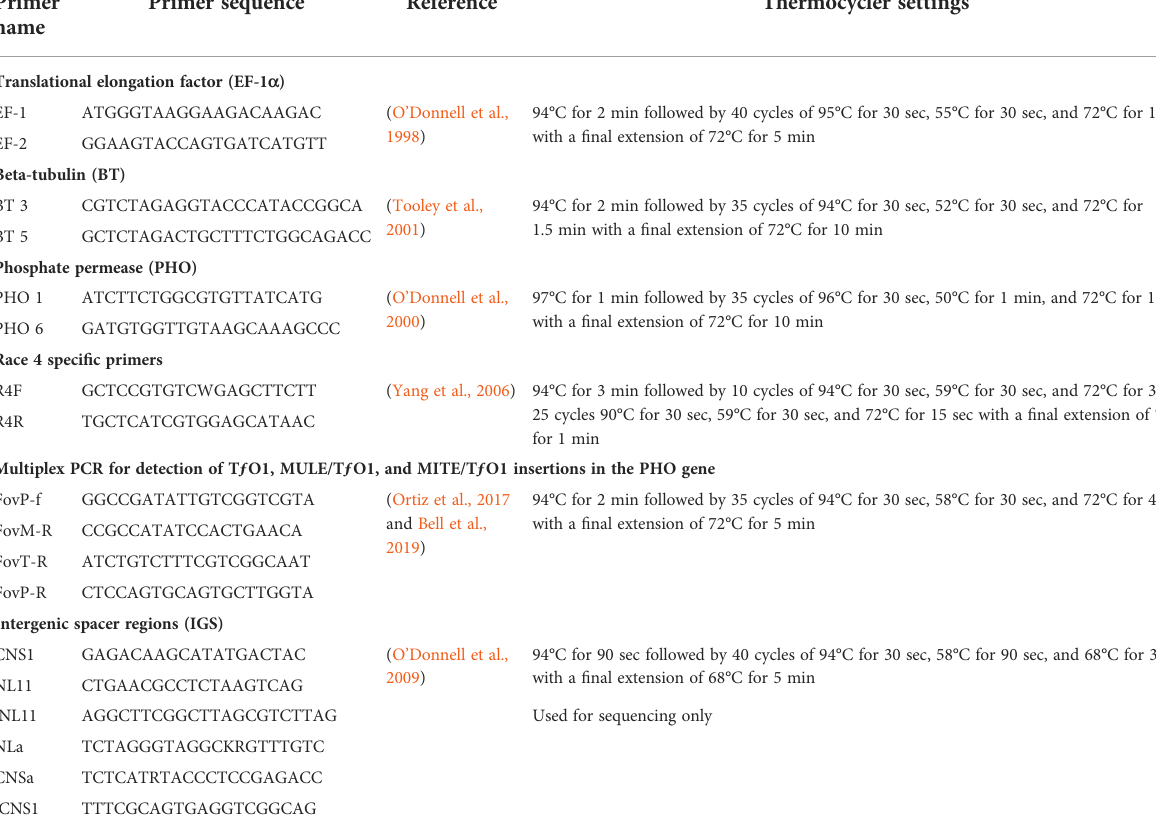
TABLE 2 Primers and thermocycler settings used for race identi fi cation of FOV isolates.